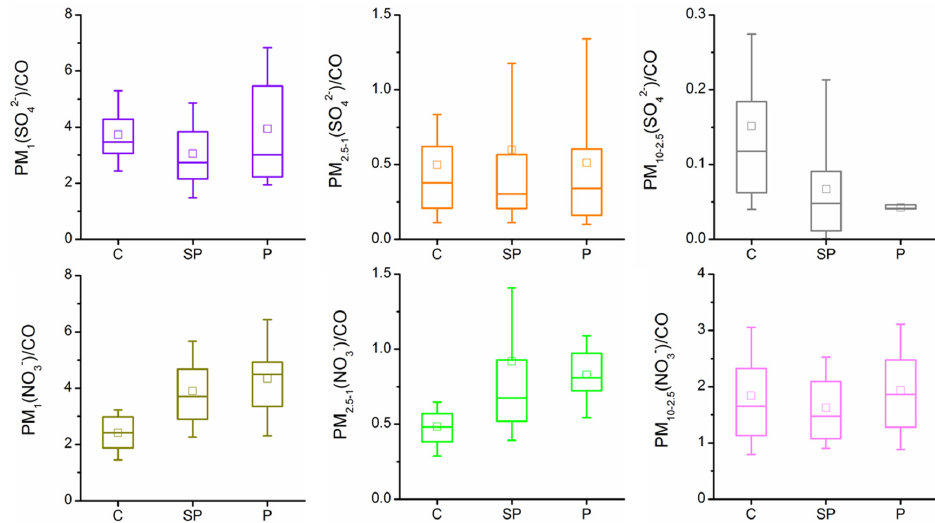
Figure 7. Variation of sulfate and nitrate concentrations in PM 1 , PM 2.5-1 and PM 10-2.5 with pollution level. The mean (square), median (horizontal line), 25th and 75th percentiles (lower and upper box), and 10th and 90th percentiles (lower and upper whiskers) are shown for each bin.